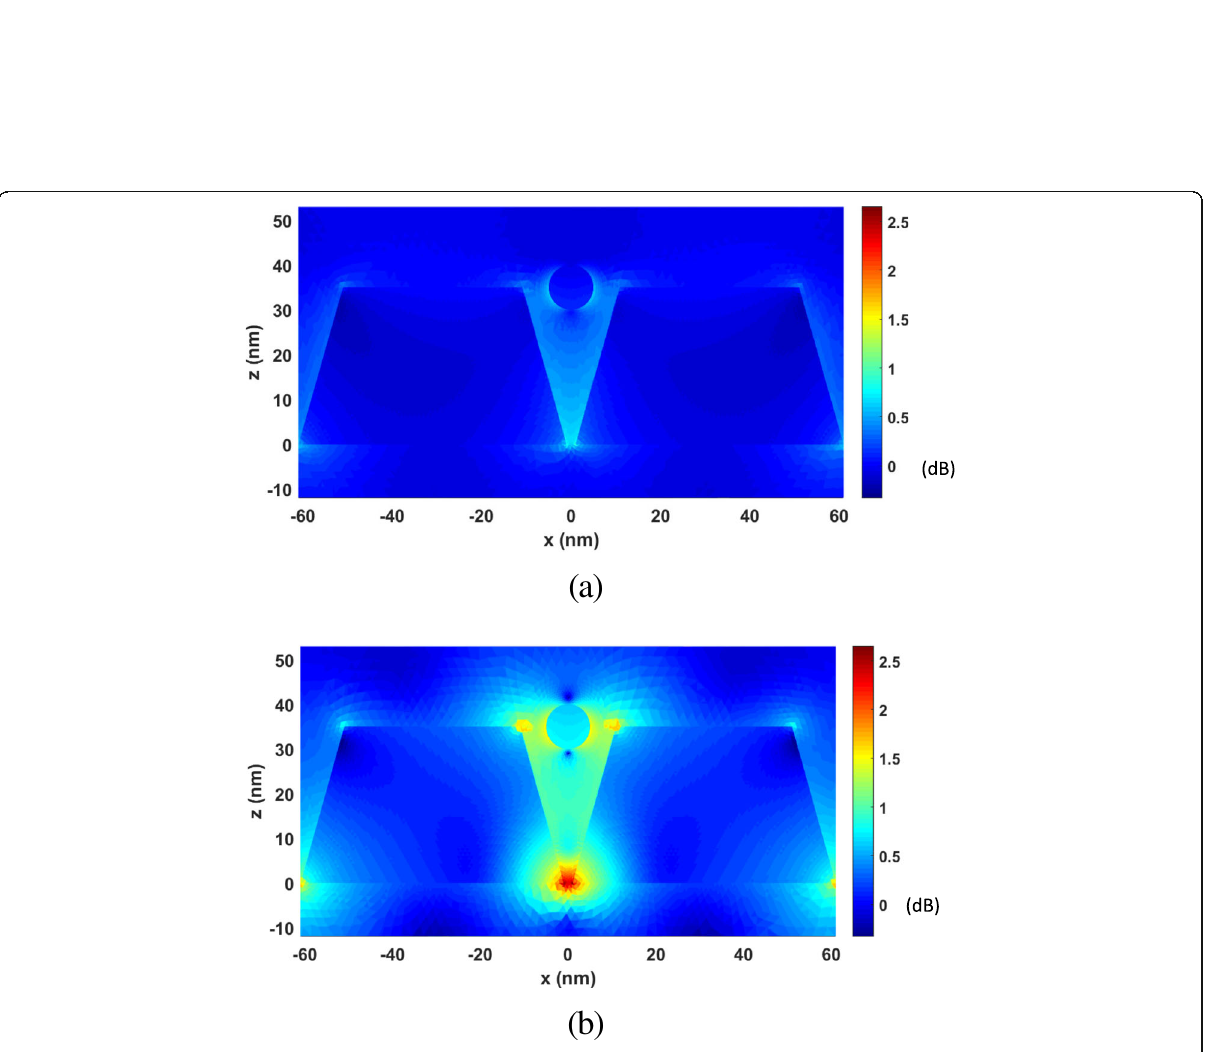
Fig. 11 The electric field enhancement distributions on the xoz plane for the system of gold truncated cone dimer. a λ = 300 nm (non-resonance wavelength). b λ = 464 nm (resonance